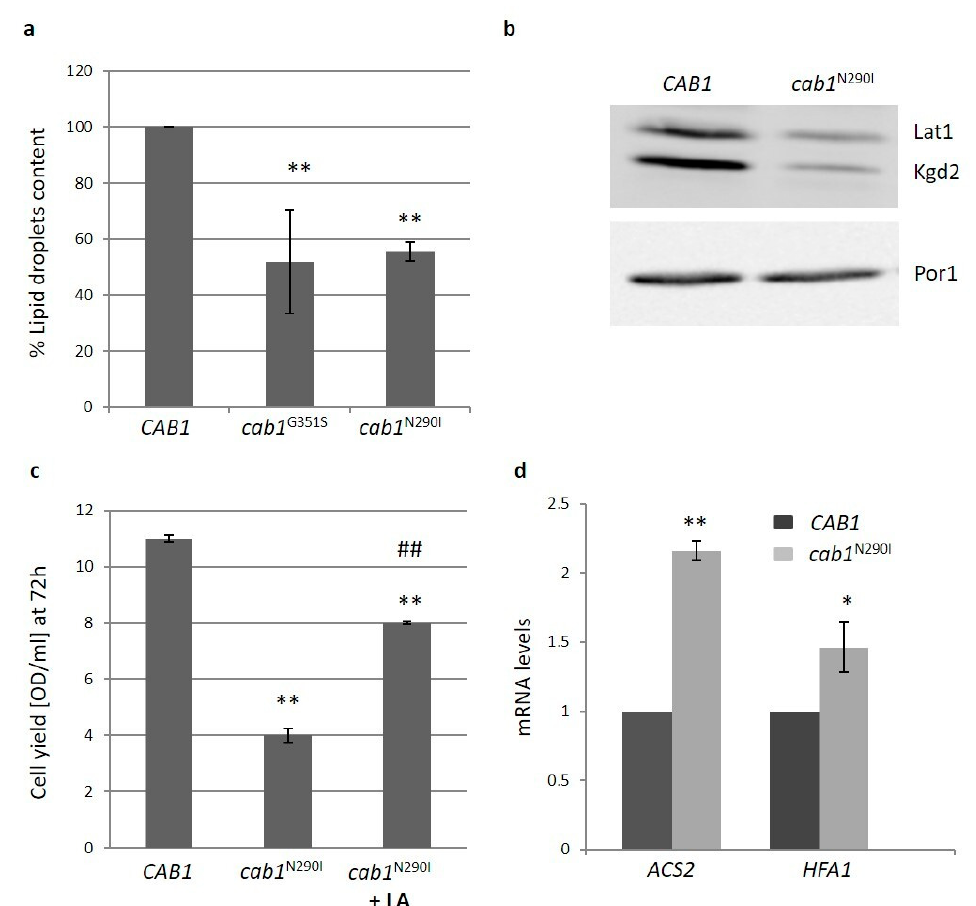
Figure 5. ( a ) The intracellular lipid droplets content was detected by fluorimetric analysis after incubation of wild-type and mutant strains with the fluorescent lipophilic dye Nile Red (4ug/mL). The values corresponding to cab1 mutants were normalized to the strain transformed with the CAB1 wild-type allele. Values are means ± standard deviation. N = 3; n = 9 for wild-type and cab1 G351S strains, n = 12 for cab1 N290I strain. **: p < 0.01. ( b ) Representative image of western blot analysis of lipoylated subunits of PDH (Lat1p) and α -KGDH (Kgd2) extracted from strain harboring pFL39 CAB1 or pFL39 cab1 N290I . N = 3; n = 3 for each strain. ( c ) Cell Yield (OD 600 /mL) was evaluated by growing wild-type and mutant strains in SC medium containing 2% ethanol for 72 h in the presence of 100 mM Lipoic Acid (LA). Values are means ± standard deviation. N = 1; n = 6 for each strain and condition. **: p < 0.01 relative to CAB1 wild-type strain and ##: p < 0.01 relative to cab1 N290I mutant strain. ( d ) The total RNA was extracted from cells grown in SC medium plus glucose 0.6%. The mRNA level of ACS2 and HFA1 genes was quantified by RT-qPCR. Values are reported as mRNA level normalized respect to wild-type Expression of ACS2 and HFA1 was normalized to the mRNA levels of the internal control ACT1. Values are means ± standard deviation. N = 1; n = 9 for each strain. *: p < 0.05; **: p <